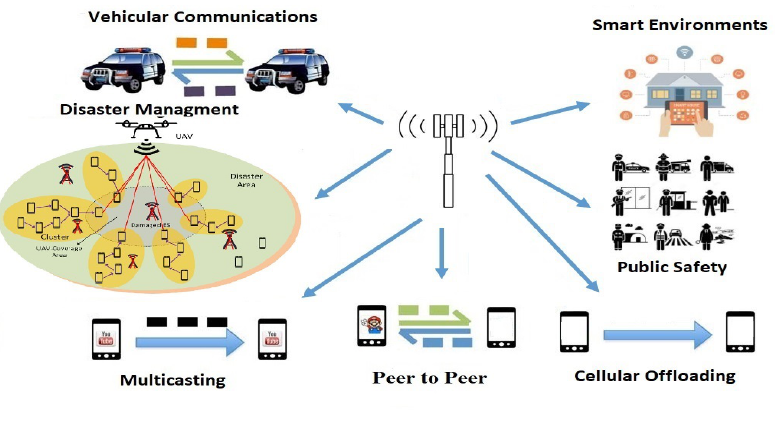
Figure 1. Samples of device-to-device (D2D)